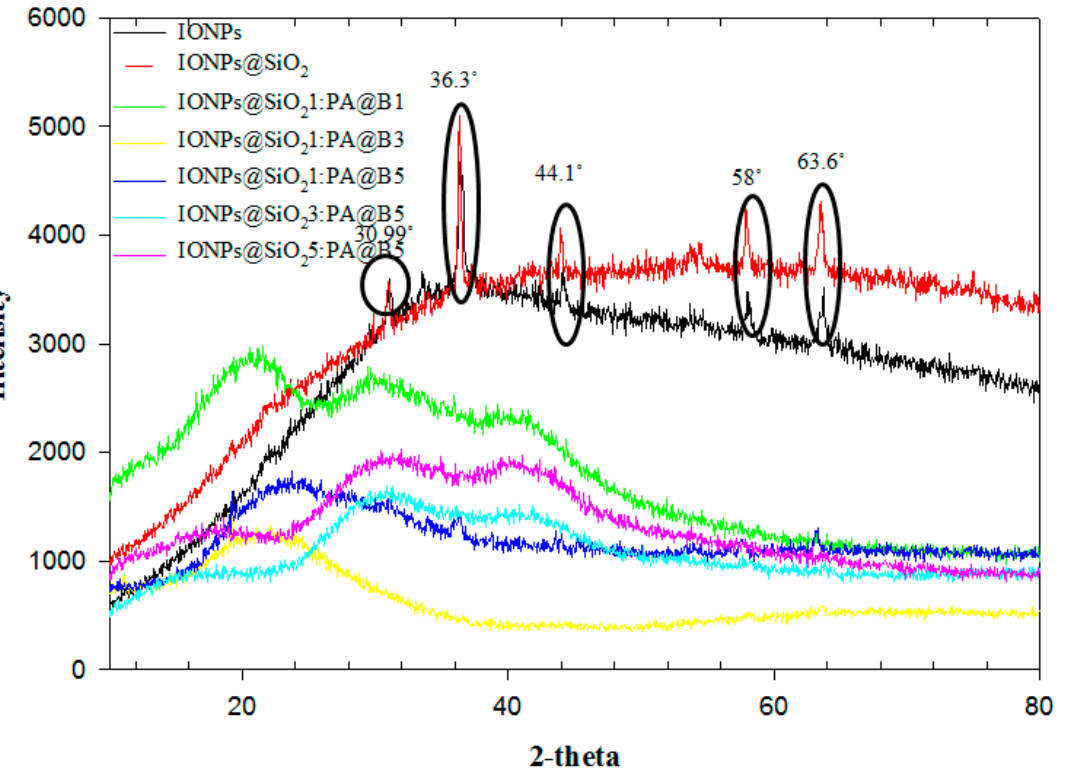
Figure 5. XRD spectra of pure IONPs, IONPs@SiO 2 , and the fabricated MCM-PA@B with different ratios of IONPs@SiO 2 and PA@B.